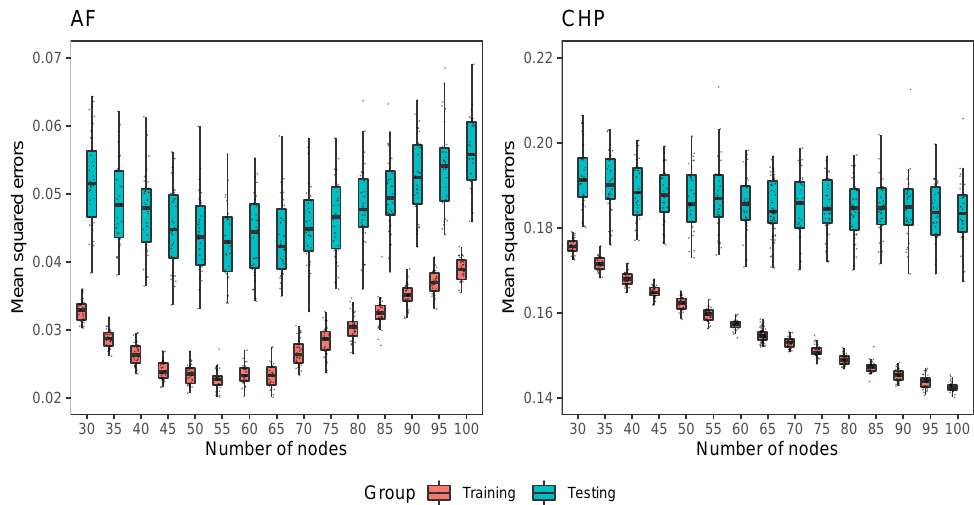
Figure 2. Box plots of 30 MSEs of one-hidden-layer LLA with J = 30,35, · · · ,100 nodes for training and testing data. The left panel is for the AF data set and the right panel is for the CHP data